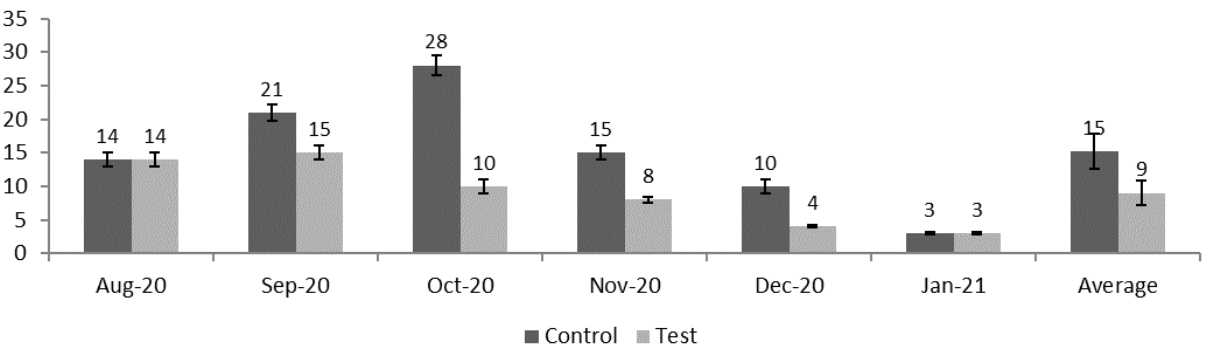
Figure 6. Average catches of mealybugs in chrome-adhesive traps per experimental piece per month.